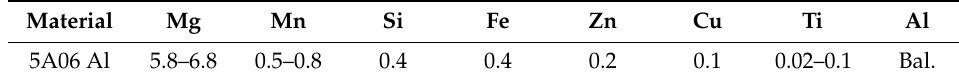
Table 2. Chemical composition of 5A06 Al alloy (wt%).